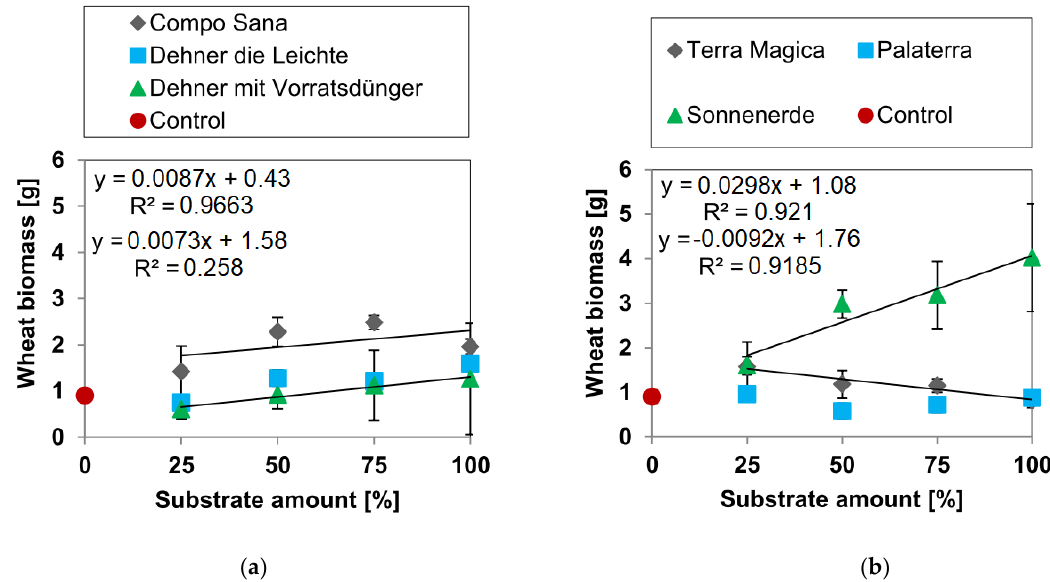
Figure 2. Wheat yield per pot after 30 days in peat-based ( a ) and biochar-based ( b ) growing media mixed with sand in different amounts. In this Figure, 0% = control (pure sand) and 100% = pure growing media. Errors bars represent standard error of the mean (n = 5). R 2 was calculated with the Spearman correlation